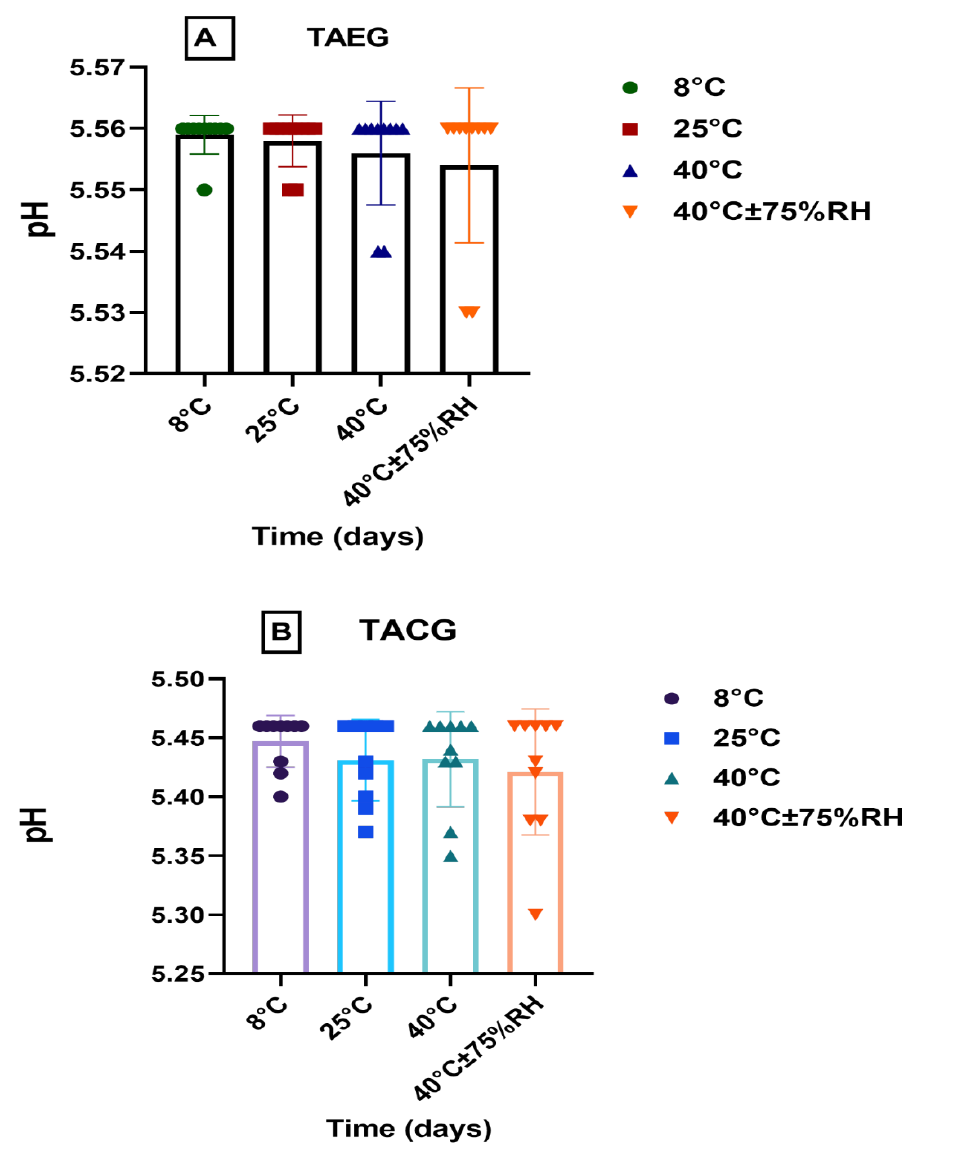
Figure 4. pH of ( A ), TAEG, and ( B ), TACG, kept at different temperatures for the study period of three months. Data are expressed as mean values ± SEM. Insignificant results were produced at 8 °C and 25 °C, 40 °C, and 40 °C ± 75% RH ( p > 0.05).